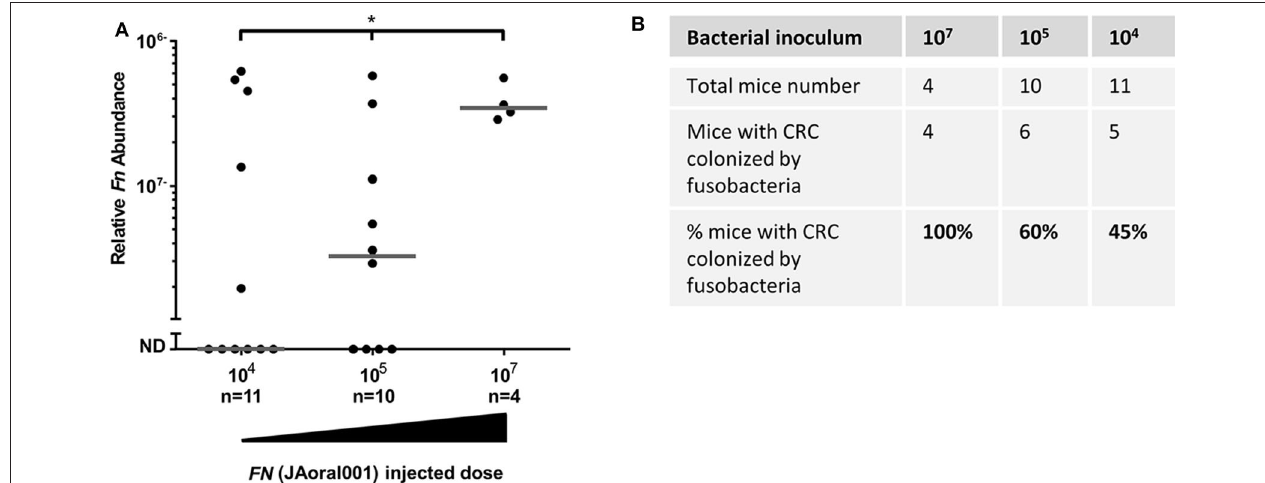
FIGURE 4 | Efficiency of CRC colonization by hematogenous fusobacteria is dose-dependent. (A) Relative fusobacterial gDNA abundance (2 − 1 Ct ), and proportion CRC colonization (B) in tumor samples from MC38 transplanted mice intravenously inoculated daily three times with 5 × 10 3 -1 × 10 4 , 5 × 10 4 -1 × 10 5 or with 5 × 10 6 -1 × 10 7 F. nucleatum JAoral001. Each symbol represents one mouse. Bar show median. * p < 0.05, the proportion of mice with fusobacterial-colonized tumors increases significantly with the amount of bacteria injected, as determined by an exact one-sided Permutation Test implemented by StatXact* ( p = 0.0442 with the scores set equal to the amount of bacteria, p = 0.04633 with the scores equal to the